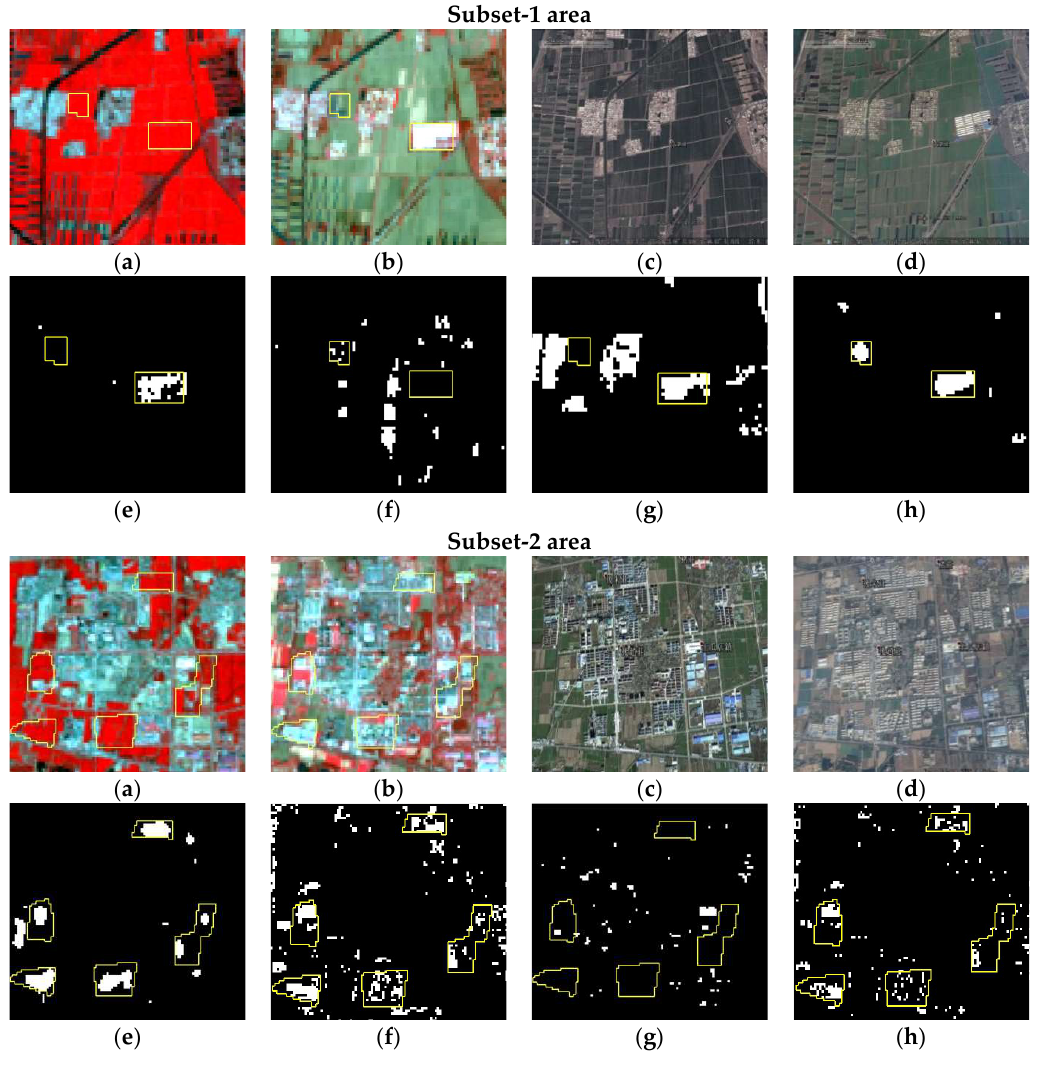
Figure 10. Change detection results for two subset areas: ( a ) Landsat images on 3 April 2010; ( b ) Landsat images on 2 October 2015; ( c ) Google earth image at 2010; ( d ) Google earth image at 2015; and change detection result of the proposed method ( e ), Continuous Change Detection and Classification (CCDC) ( f ), change vector analysis (CVA) ( g ) and post-classification comparison (PCC) ( h ).